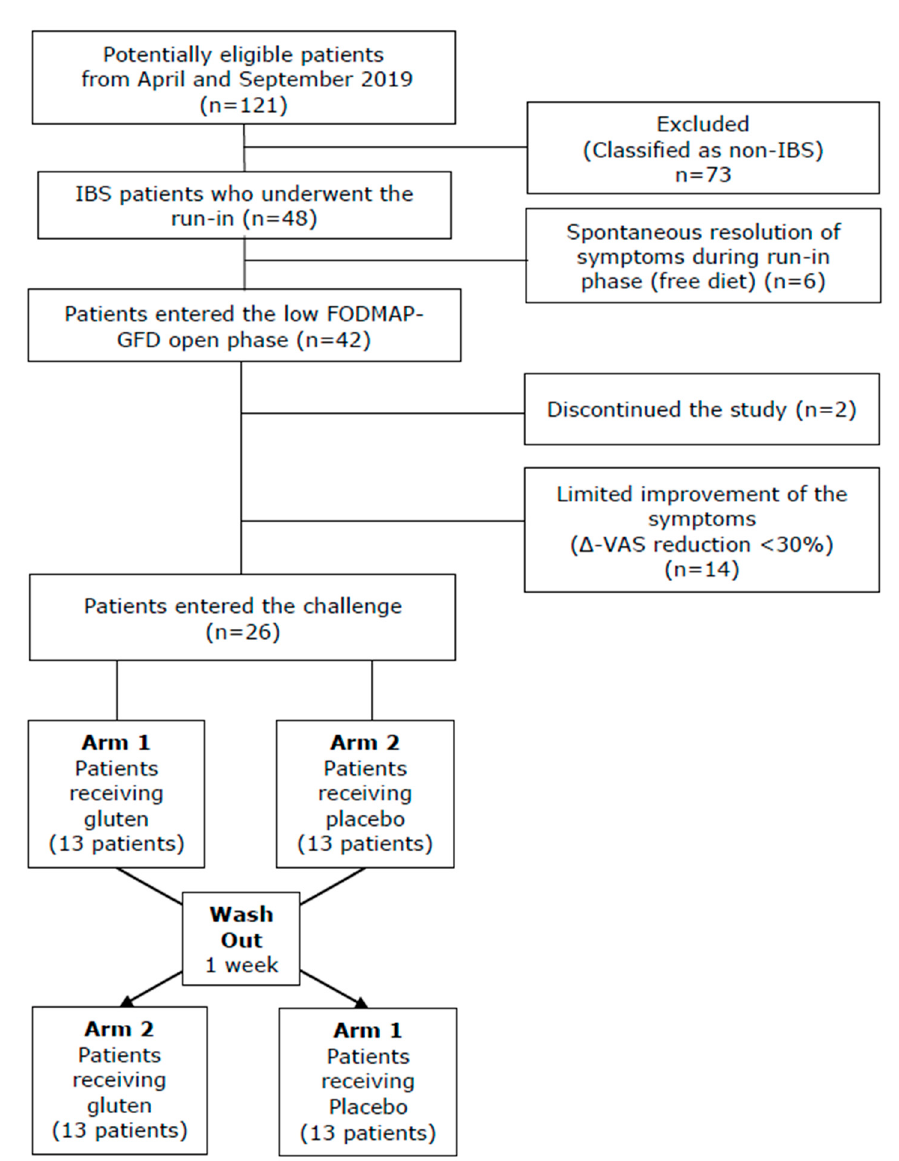
Figure 2. Flow diagram describing the process from assessment for eligibility through the completion of the study. IBS, irritable bowel syndrome; FODMAP, fermentable oligosaccharides, disaccharides, monosaccharides and polyols; VAS, visual analogue